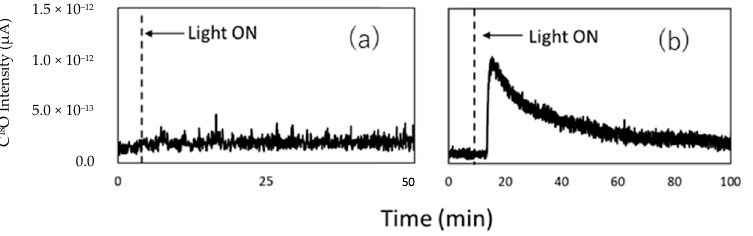
Figure 35. Yield of C 18 O after exchanging surface oxygen with ( a ) H 216 O and ( b ) H 218 O. Reprinted from [30].